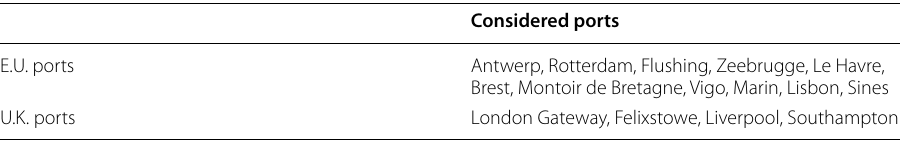
Table 1 Major EU and U.K. ports in the loop